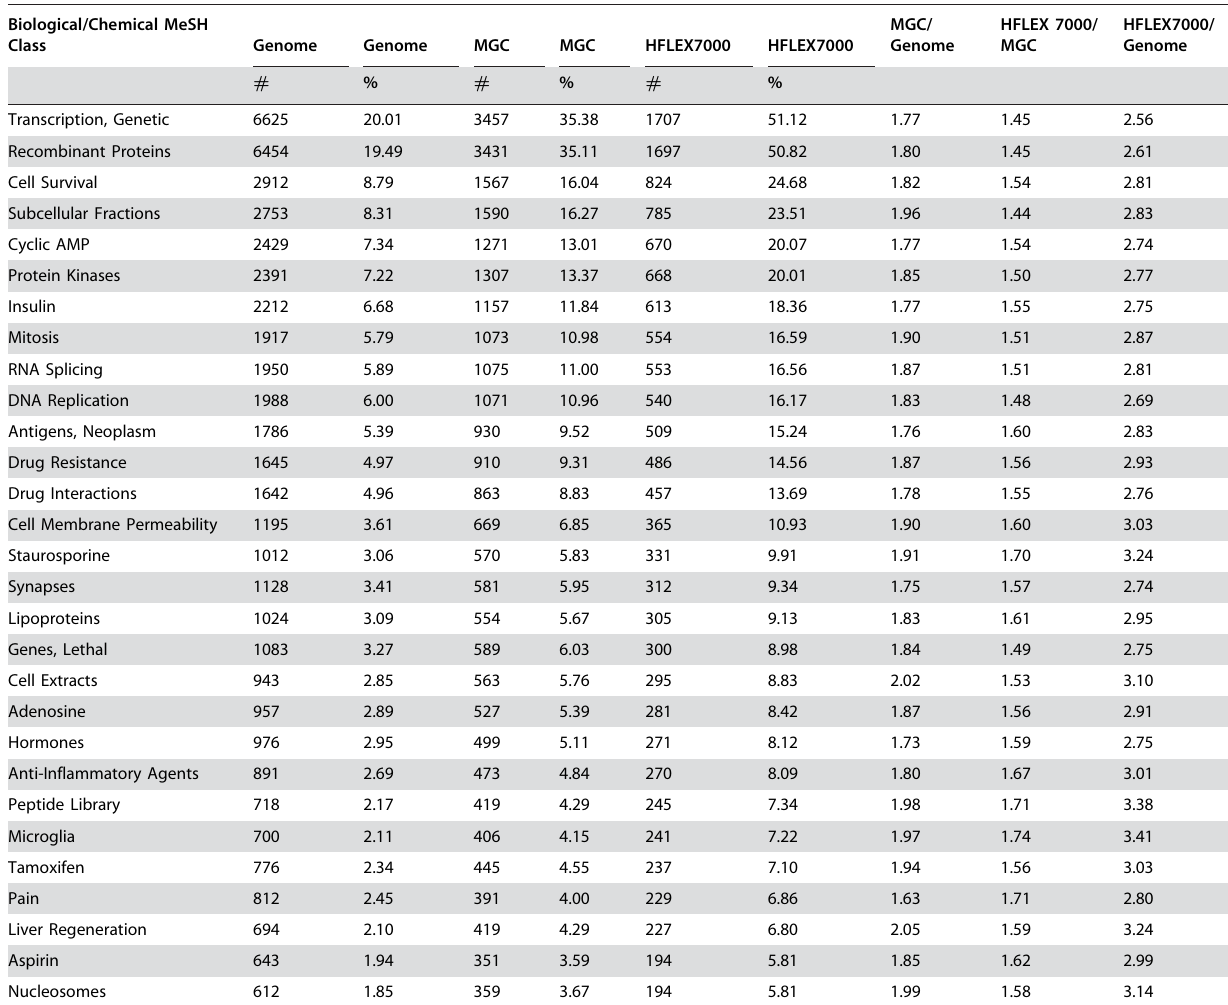
Table 2. Biological and Chemical MeSH Class Analysis for Genes Associated in Publications with MeSH Class; Examples .. ... .... ... ... .... ... ... .... ... ... .... ... ... .... ... ... .... ... ... .... ... ... .... ... ... .... ... ... .... ... ... .... ... ... .... ... ... .... ... ... .... ... ... . Biological/Chemical MeSH